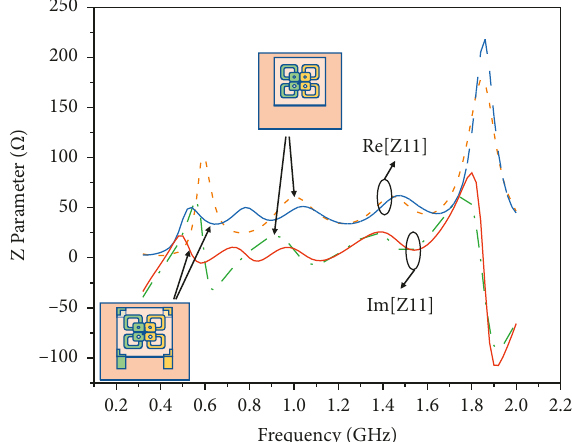
Figure 3: Simulated Z-parameters of the antenna with/without parasitic elements.